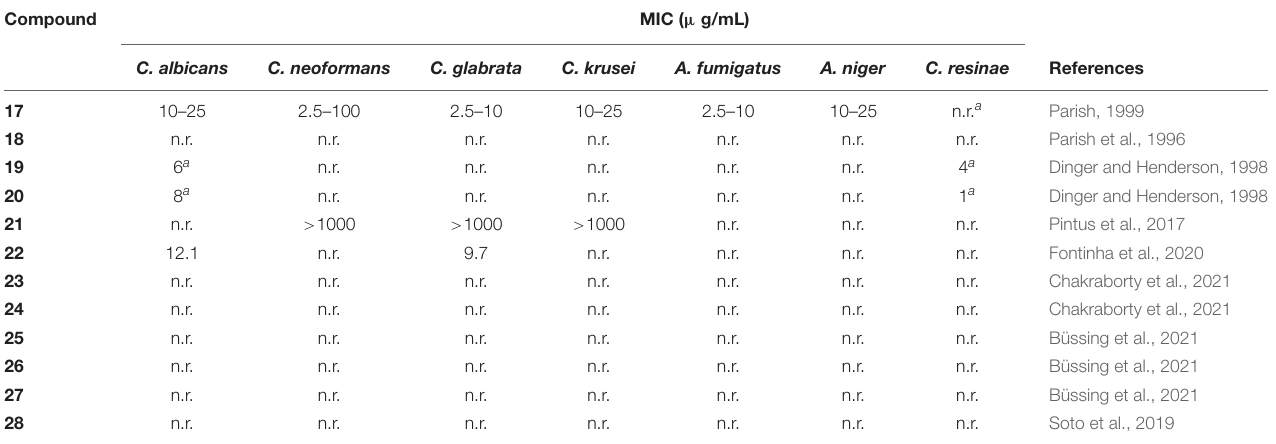
TABLE 5 | Antifungal activity (MIC) of the gold(III) complexes.